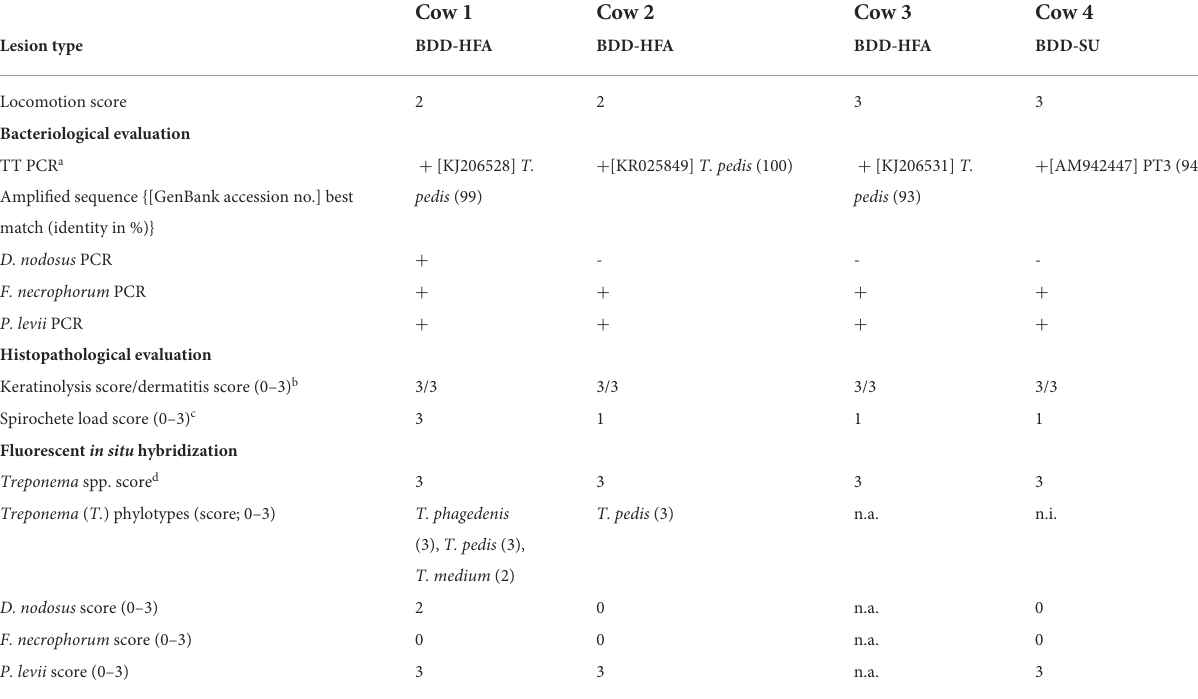
TABLE 1 Locomotion score and results of bacteriological and histopathological investigations as well as fluorescent in situ hybridization of biopsies collected from four non-healing lesions associated bovine digital dermatitis (BDD). Cow 1 Cow 2 Cow 3 Cow